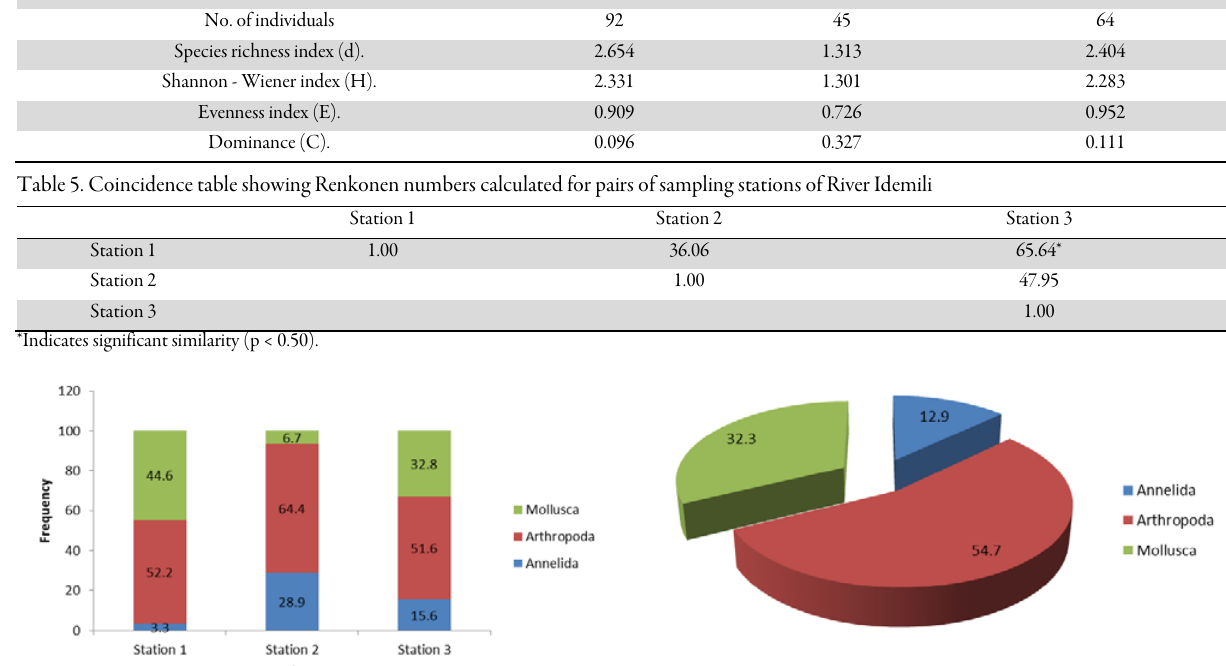
Fig. 3. Relative percentage composition of major macro- invertebrate phyla of River